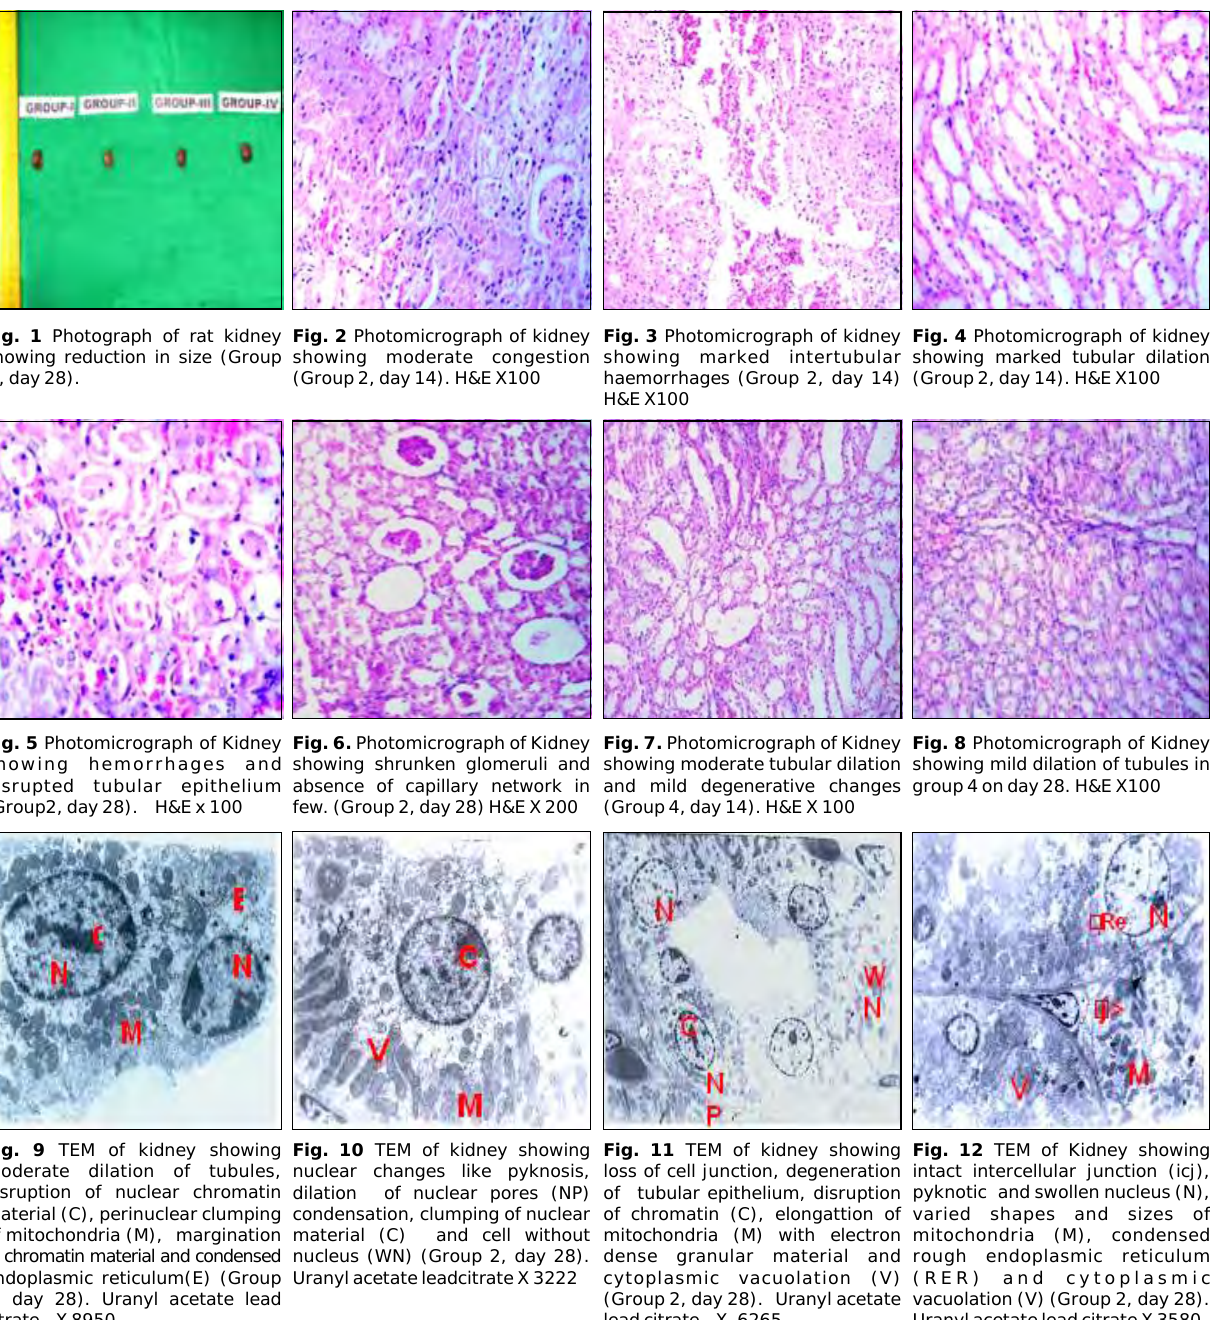
Fig. 11 TEM of kidney showing loss of cell junction, degeneration of tubular epithelium, disruption of chromatin (C), elongattion of mitochondria (M) with electron dense granular material and cytoplasmic vacuolation (V) (Group 2, day 28). Uranyl acetate lead citrate X 6265